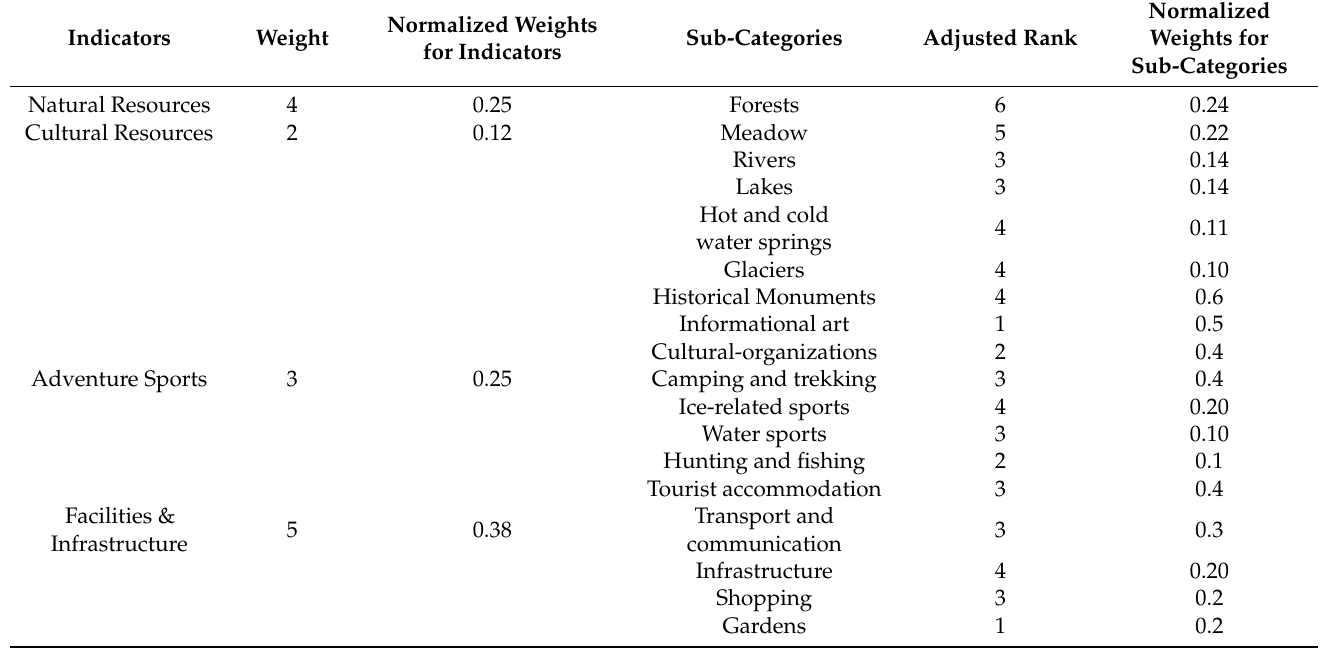
Table 2. Parametric evaluation of Tourism Potential